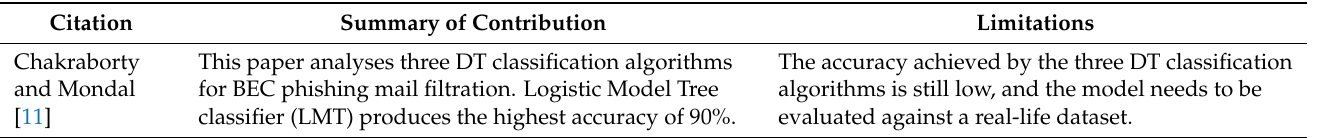
This paper analyses three DT classification algorithms for BEC phishing mail filtration. Logistic Model Tree classifier (LMT) produces the highest accuracy of 90%.